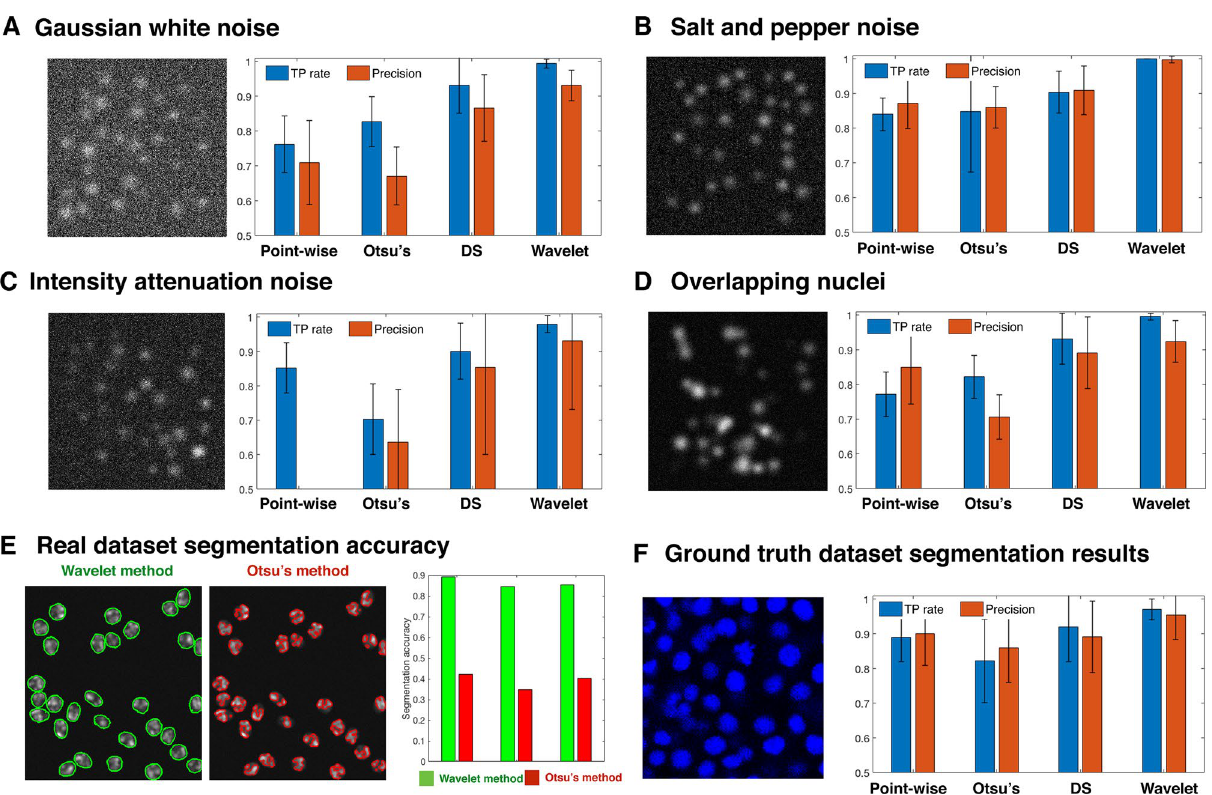
Figure 3. Performance criteria and segmentation accuracy of four segmentation methods on synthetic images and ground truth image datasets. ( A – D ) True positive (TP) rate and Precision on four kinds of noisy synthetic images using three segmentation methods and the wavelet method. Error bars indicate standard deviation. ( A ) Samples of synthetic images (N = 20) Gaussian white noise and TP rate and Precision when applying point- wise method, Otsu method, DS method and wavelet-based segmentation method. ( B ) Samples of salt and pepper noise synthetic images (N = 20) and TP rate and Precision for four segmentation methods. ( C ) Intensity attenuation noisy synthetic image samples (N = 20) and TP rate and Precision for four segmentation methods. ( D ) Samples of overlapping synthetic image samples (N = 20) and TP rate and Precision for four segmentation methods. ( E ) Segmentation accuracy when applying Otsu method and wavelet-based segmentation method on three Fluo-N2DH-GOWT1 sample images. ( F ) True positive rate and Precision on five ground truth images when using point-wise method, Otsu method, DS method and wavelet-based segmentation